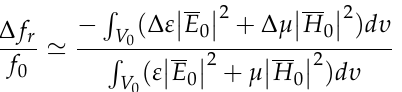
Figure 6. Effect of the SUT’s thickness on CC ‐ SRR and SC ‐ SRR sensors’ resonance frequency and notch depth.